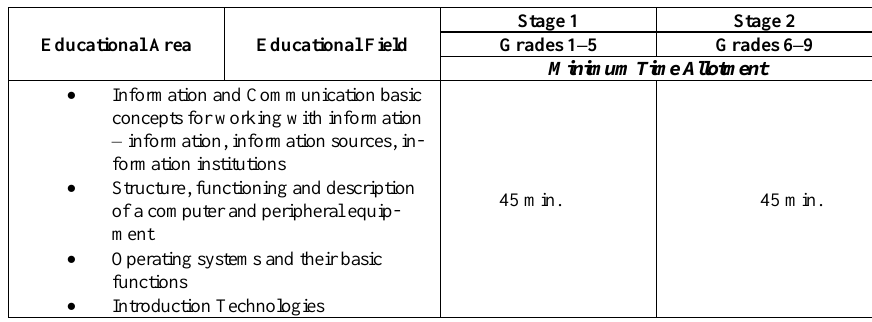
Table 1. Framework